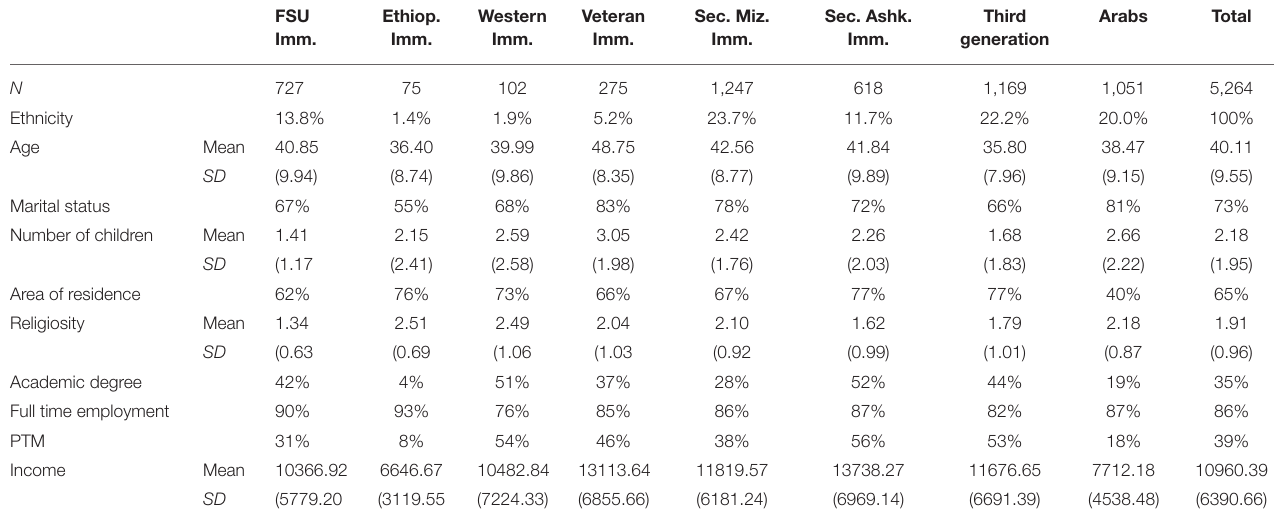
TABLE 1B | Socio-demographic characteristics of the sample—Men.